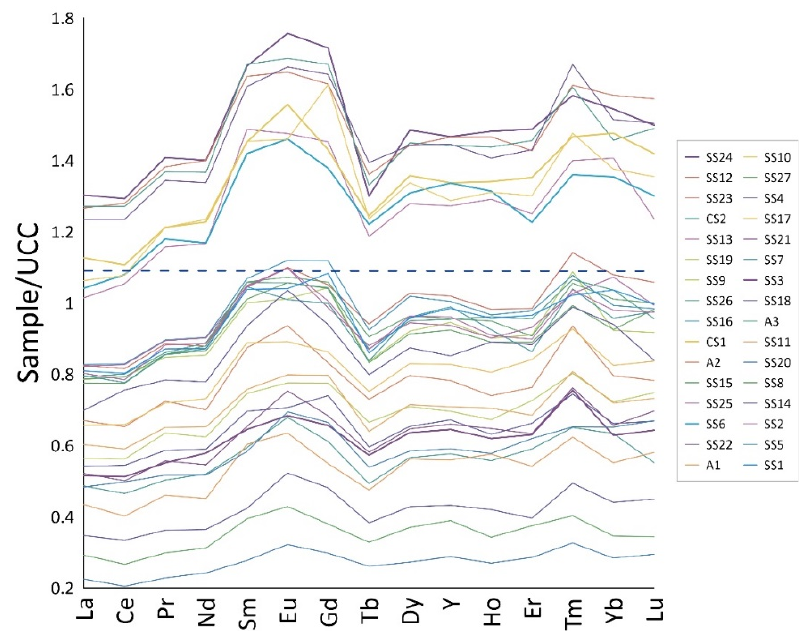
Figure 7. Upper ‐ Continental Crust (UCC) normalized REEs patterns for the studied samples.